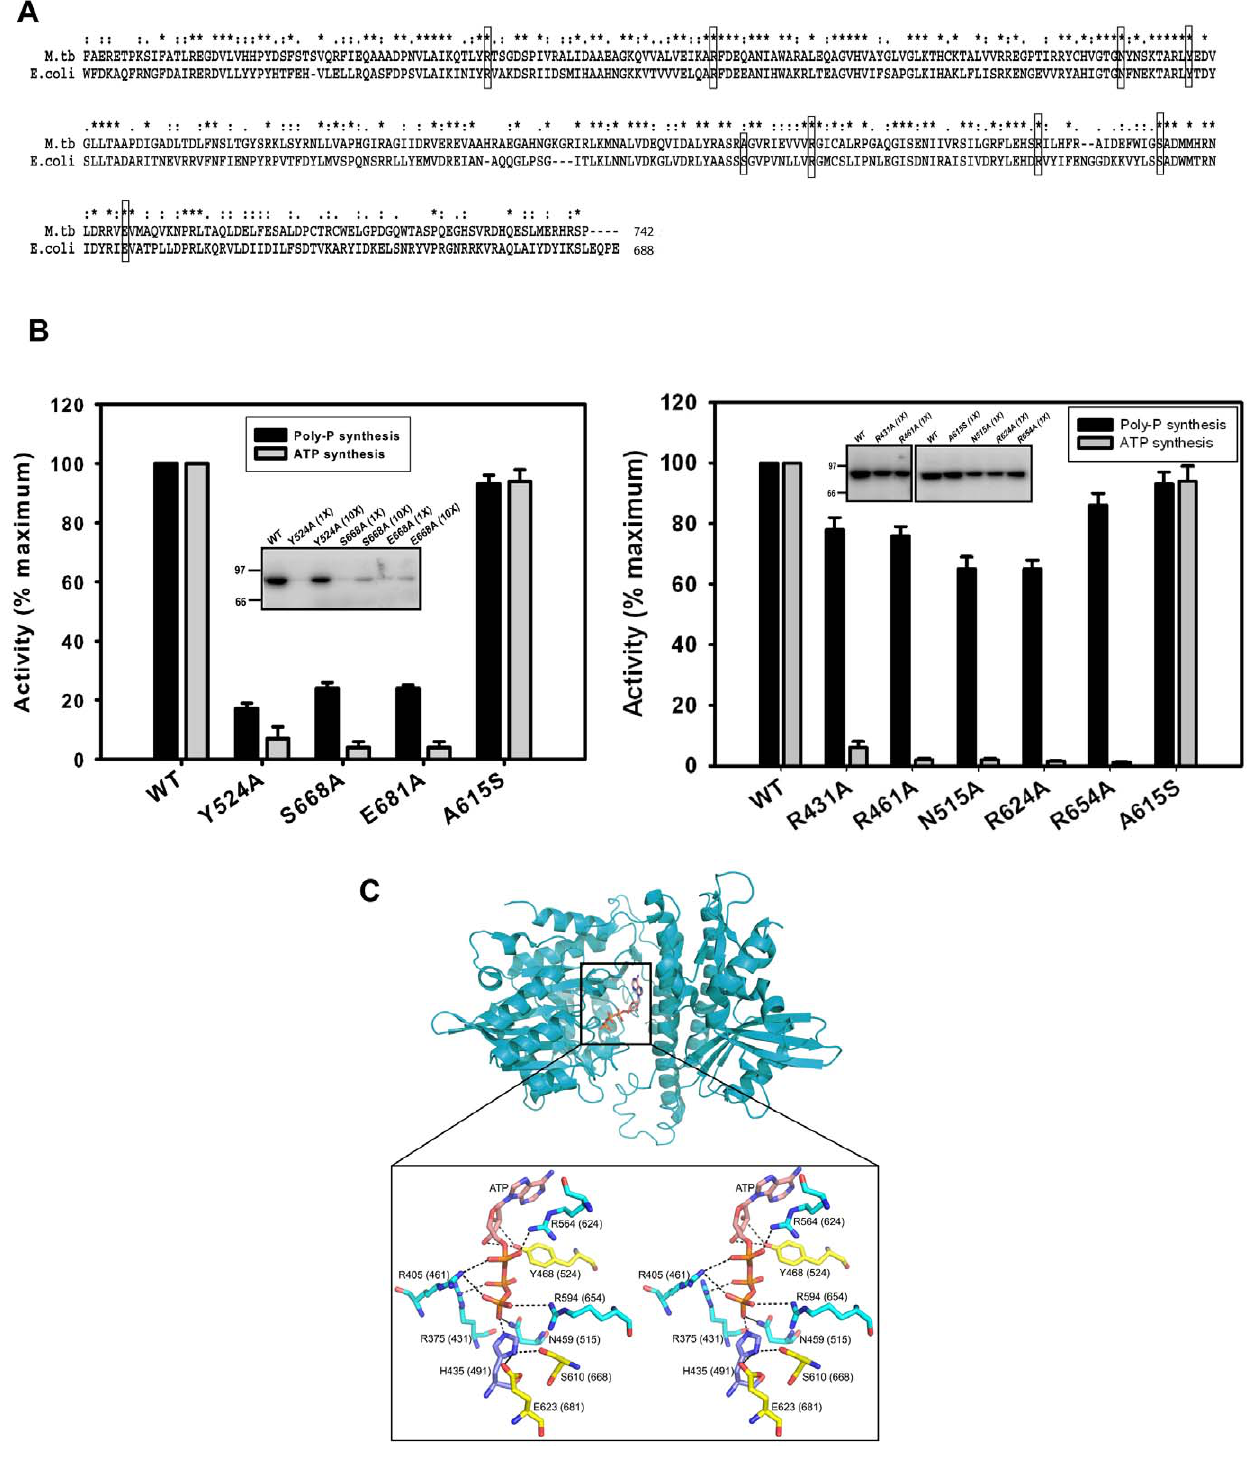
Figure 3. Amino acid residues involved in poly-P and ATP syntheses are distinct. A. Alignment of amino acid residues from M. tuberculosis (M.tb; residues 378–742) and E. coli (E. coli; residues 322–687). Residues selected for mutations are highlighted in box. B. Effect of mutations on poly-P and ATP synthesizing activities of mPPK1. Mutations affecting both the activities (left panel) and only ATP synthesis (right panel). The amino acid Ala- 615 which is away from active site was chosen as a control. Activities in each case are expressed as % wild-type control. Inset : Autophosphorylation profile of different C1 and C2 domain mutants (Notations used: 1X=500 ng protein/reaction and 10X=5 m g protein/reaction). C. The PPK1 from E. coli (PDB ID: 1XDP) showing the conserved C- terminal domain residues chosen for the mutational analysis. The carbon residues shown in yellow represent the mutation affecting both poly-P and ATP syntheses while cyan represents the mutation affecting only ATP synthesis. The conserved phospho-histidine (His-491) residue is shown in purple (carbon atom). The mPPK1 residue numbers are shown in parentheses.